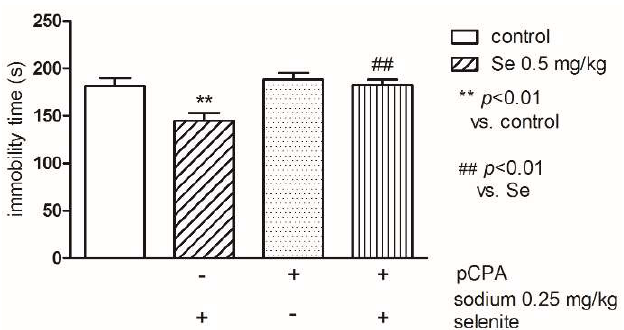
Figure 6. The effects of pretreatment with p-chlorophenylalanine (pCPA) on the antidepressant-like effect of sodium selenite in the FST in mice. The values represent the mean ± SEM. pCPA was injected at dose of 100 mg/kg for four consecutive days. Sodium selenite was injected IP 30 min before the test. ** p < 0.001 vs. control vehicle-treated group, ## p < 0.01 vs. pCPA (Bonferroni’s test).